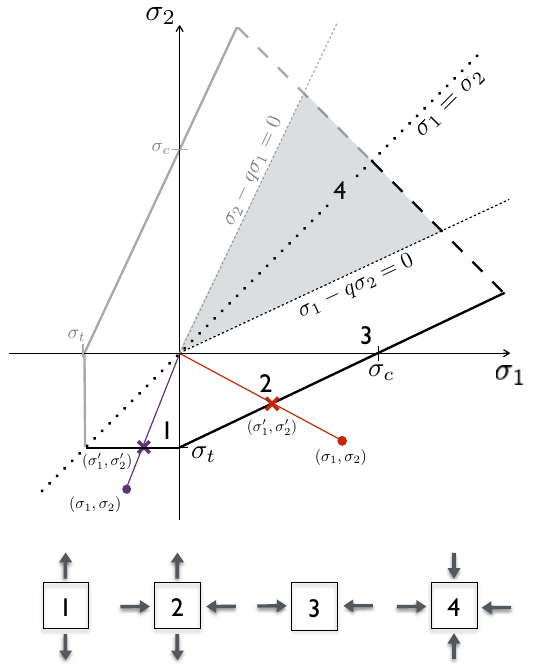
Figure 2. Damage criterion of the Maxwell-EB model in the princi- pal stresses plane (solid line) combining the Mohr–Coulomb and tensile stress criteria. The thick dashed line represents a biaxial compression truncation that closes the envelope but is not applied in the present model. Compression is taken positive and the dot- ted line indicates the σ 1 = σ 2 axis. Numbers indicate the states of (1) uniaxial tension, (2) biaxial tension and compression, (3) uni- axial compression and (4) biaxial compression and their location relative to the envelope. The calculation of the distance to the dam- age criterion d crit , defined by the intersection ( σ (cid:48) , σ (cid:48) ) of the line 1 2 relating the state of stress ( σ 1 , σ 2 ) of a given element to the origin of the principal stress plane, is represented in red in the case of the Mohr–Coulomb criterion being exceeded and in purple in the case of the tensile strength criterion being